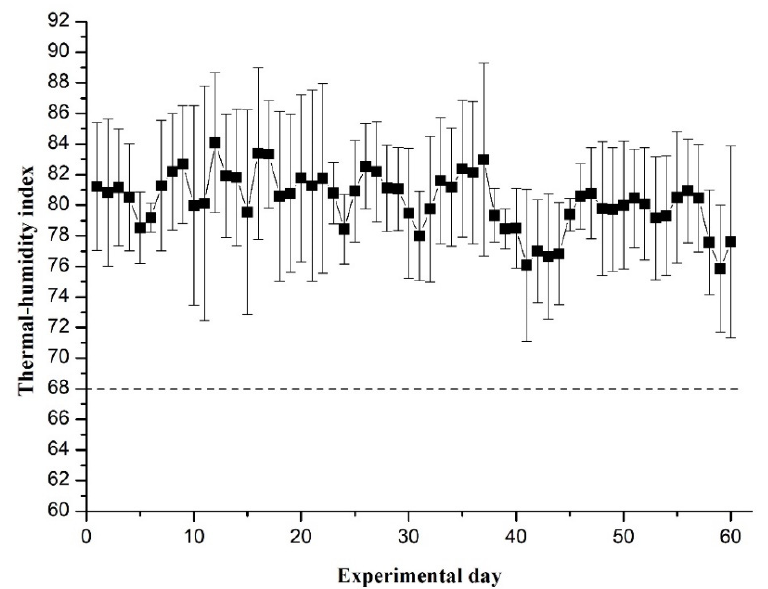
Figure 1. Thermal-humidity index of experimental days. The error bar stands for the standard error of thermal-humidity index of every experimental day. Table 1. Rectal temperature and respiratory rate of lactating cows fed the total mixed rations (TMR) containing unfermented (UM) and fermented (FM) yellow wine lees (YWL) mix. Treatment 1 Items SEM p -Value Control UM FM Rectal-Temperature 38.6 Table 2. Total phenolic and flavonoid contents and in vitro antioxidant activity of soybean meal (SBM), and unfermented (UM) and fermented yellow wine lees mix (FM). Items SBM UM FM SEM p -Value Total phenolic content, mg GAE/100 g 202 c 582 b 676 a 16.3 <0.01 Total flavonoid content, mg CE/100 g 185 c 273 b 352 a 6.25 <0.01 Reducing power 0.28 b <0.01 Superoxide radical scavenging ability, % 21.5 c <0.01 Hydroxyl radical scavenging ability, % <0.01